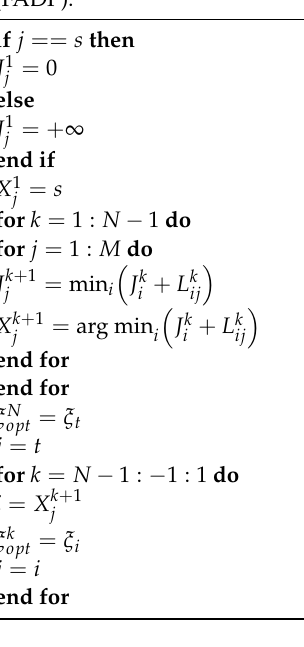
Algorithm A1 General implementation of the Forward Approach to Dynamic Programming